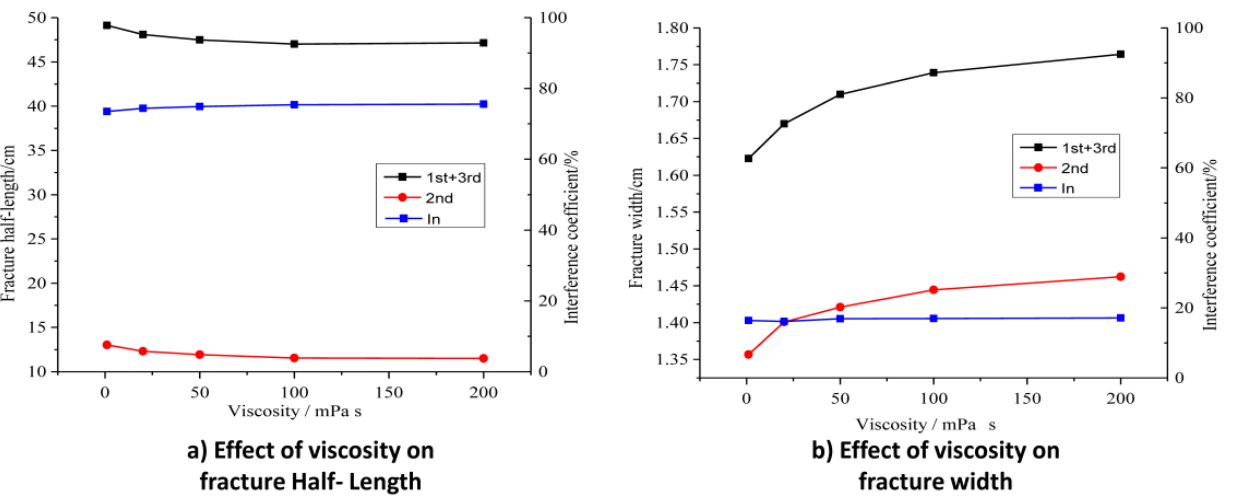
Figure 10: Results of fracture morphology for fracture propagation when the viscosity of fracturing fluid is different. The research shows that the short and wide fracture can be obtained by increasing the viscosity of the fracturing fluid. conducive to increasing the volume of the reservoir stimulated by hydraulic